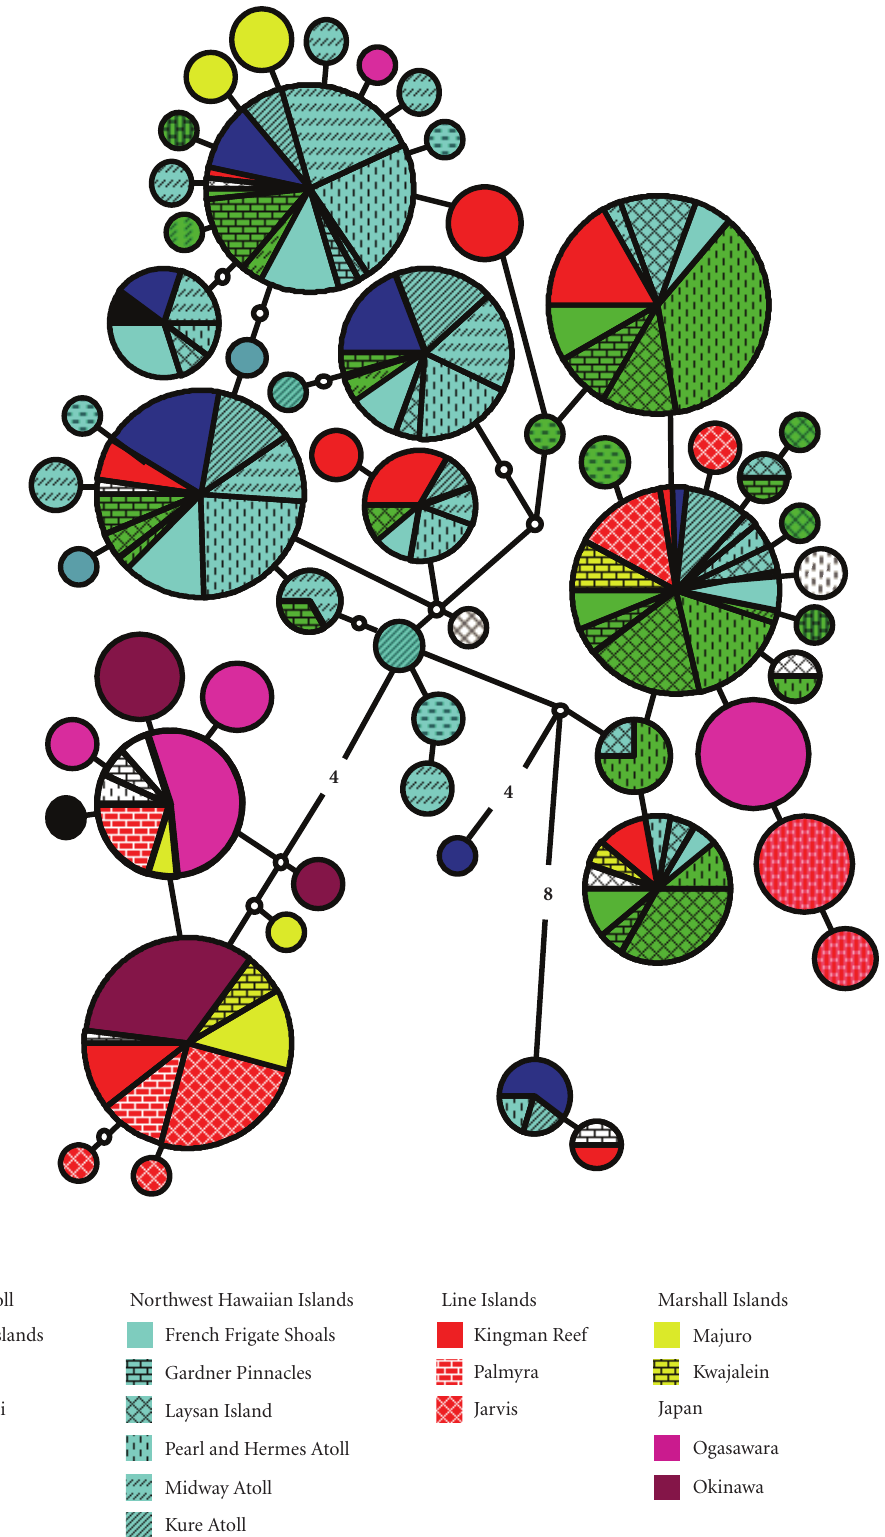
Figure 2: Haplotype network for Holothuria atra . Each circle represents a unique haplotype connected by a line to those that di ff er by one base pair. Nodes on lines indicate a missing haplotype, and numbers represent multiple missing haplotypes. Each haplotype is color coded by site, and circle size is proportional to frequency. The smallest circles represent one occurrence of a